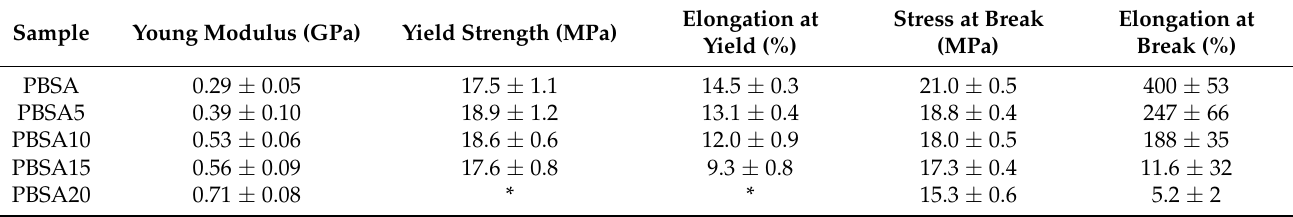
Figure 8. Dog-bone specimens of PBSA and PBSA/BC composites for tensile tests. Table 3. Mechanical properties of PBSA and PBSA/BC specimens. Mean values ± standard deviation of 5 replicates. (*) Yield strength and elongation at yield equal stress at break and elongation at break,